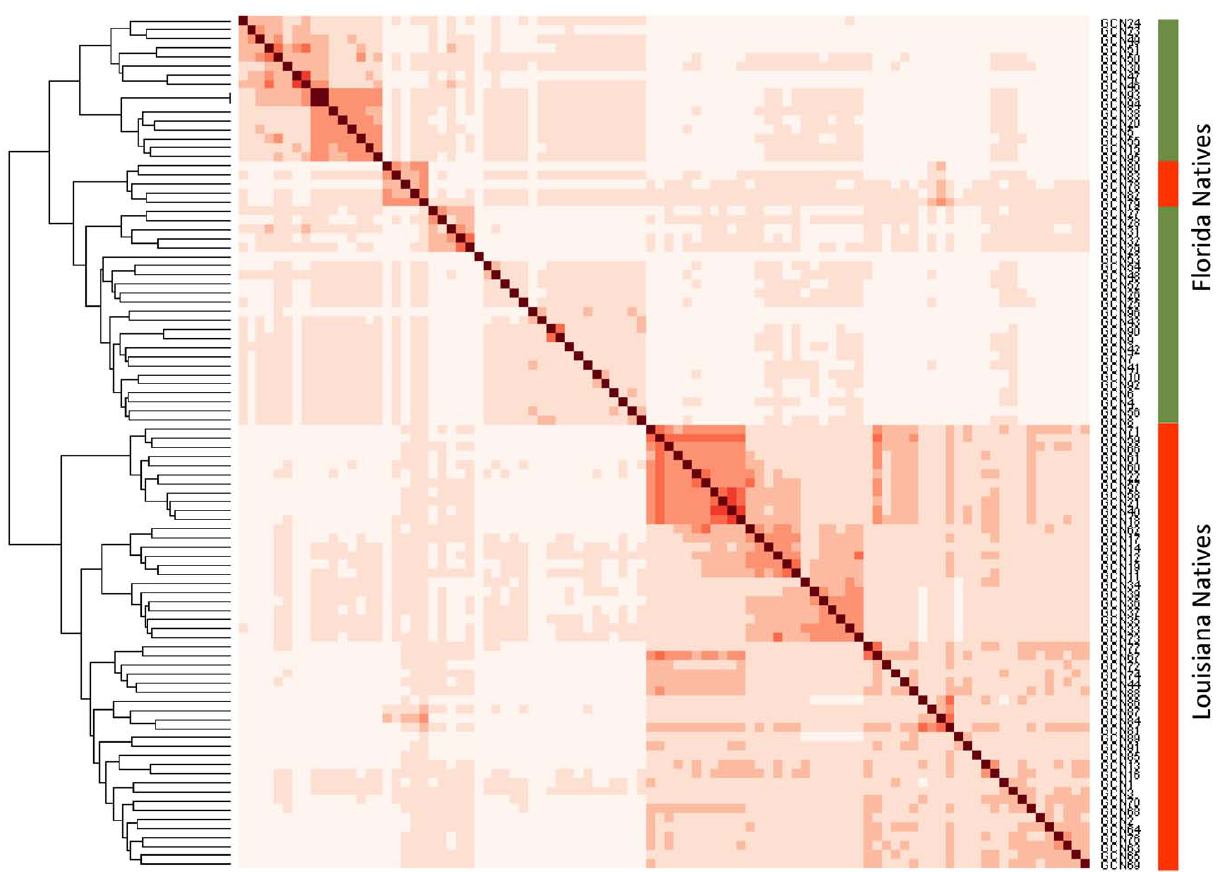
Figure 1. Allele sharing heat map of the Gulf Coast Native. The proportion of alleles shared ( A s ) between individuals was used to construct an ordered heat-map and dendogram. Cell colour represents the strength of allele sharing, where darker color indicates increasing allele sharing and relatedness between animals. As a guide, the lightest colors represent A s values , 0.65 and the darkest colors A s values . 0.80. Samples compared against themselves appear on the diagonal with the maximum A s value of 1 and darkest colour. Two blocks were revealed that correspond to membership of either the Florida Native (indicated at right in green) or Louisiana Native (red).